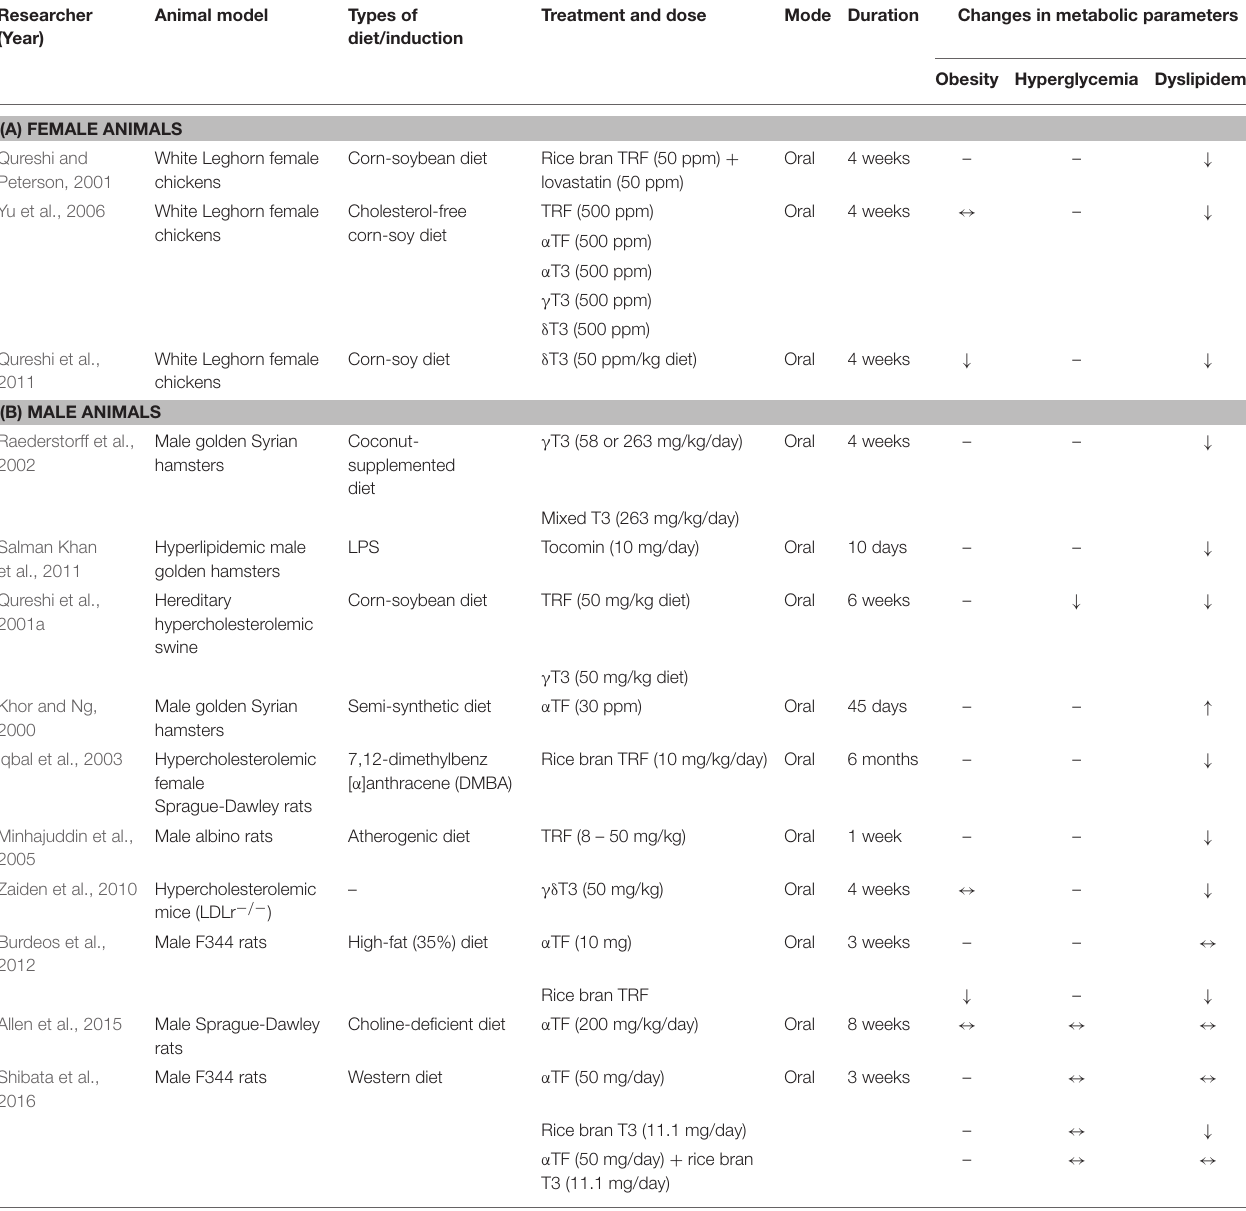
TABLE 3 | The effects of vitamin E on metabolic parameters in hyperlipidemic animal models.